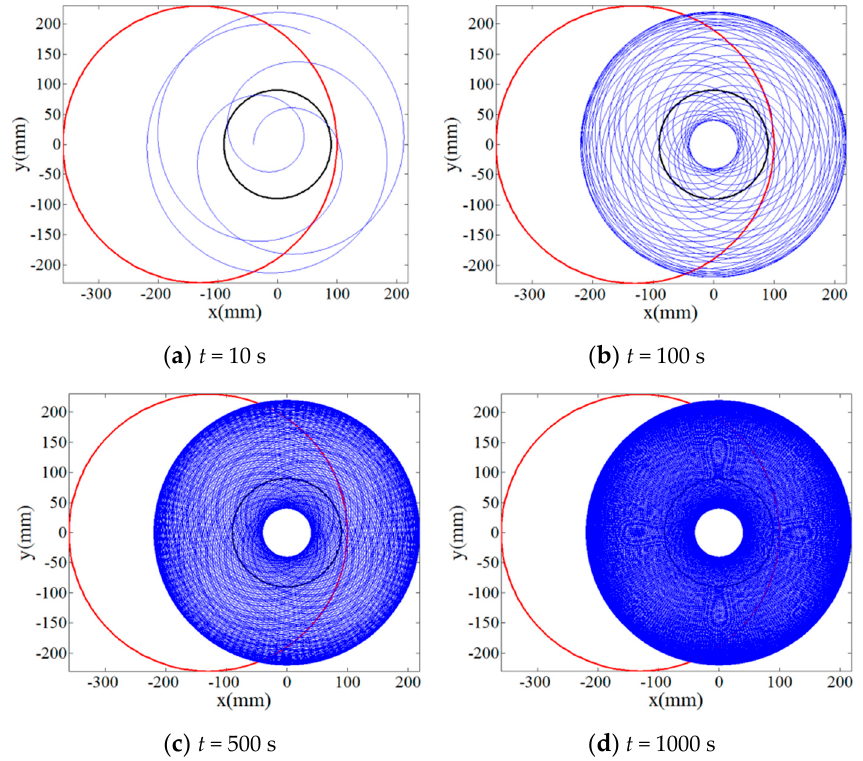
Figure 4. Relationship between trajectory of the single abrasive particle on target surface at i pw = 0.3819… and lapping time ( a ) t = 10 s; ( b ) t = 100 s; ( c ) t = 500 s; ( d ) t = 1000 s.